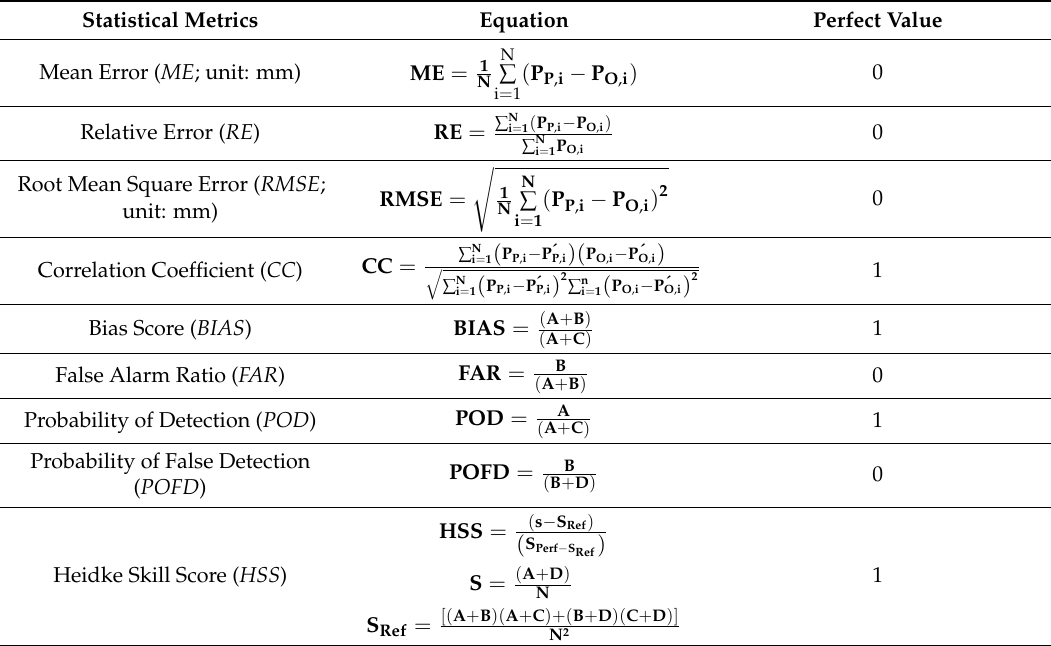
Table 3. Statistical metrics applied in the evaluations